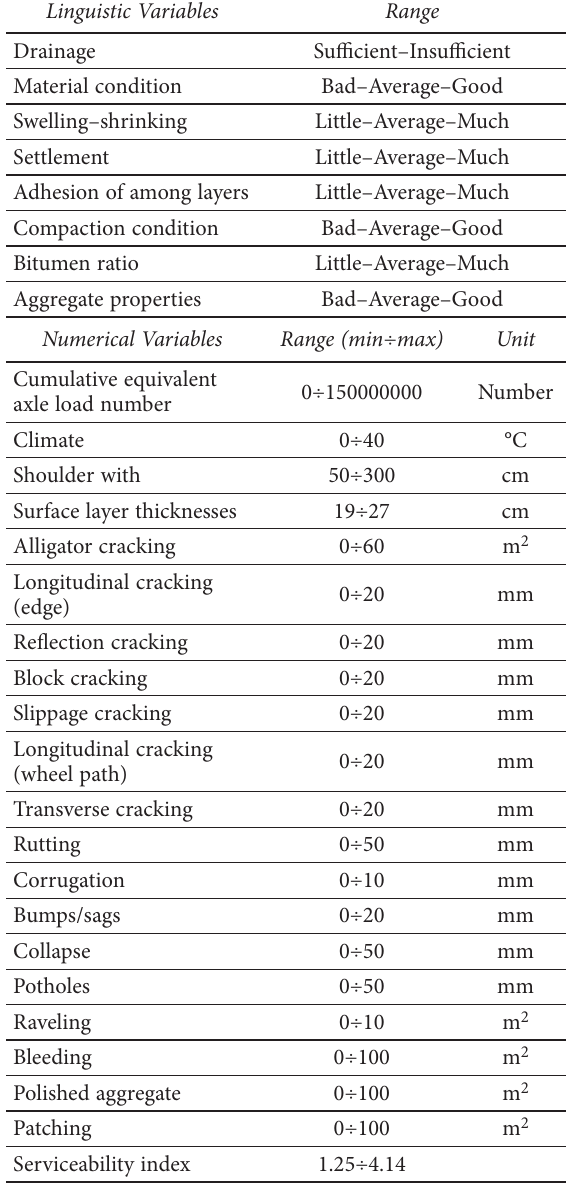
Fig. 5. Membership function of rutting Table 2. Variables used in the model and ranges